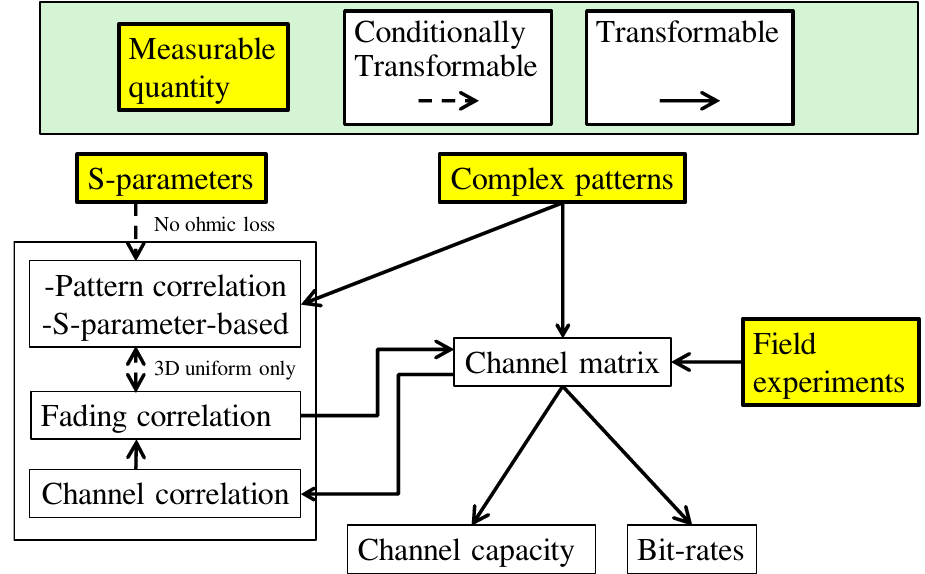
Figure 6. Measurable quantities and yielded